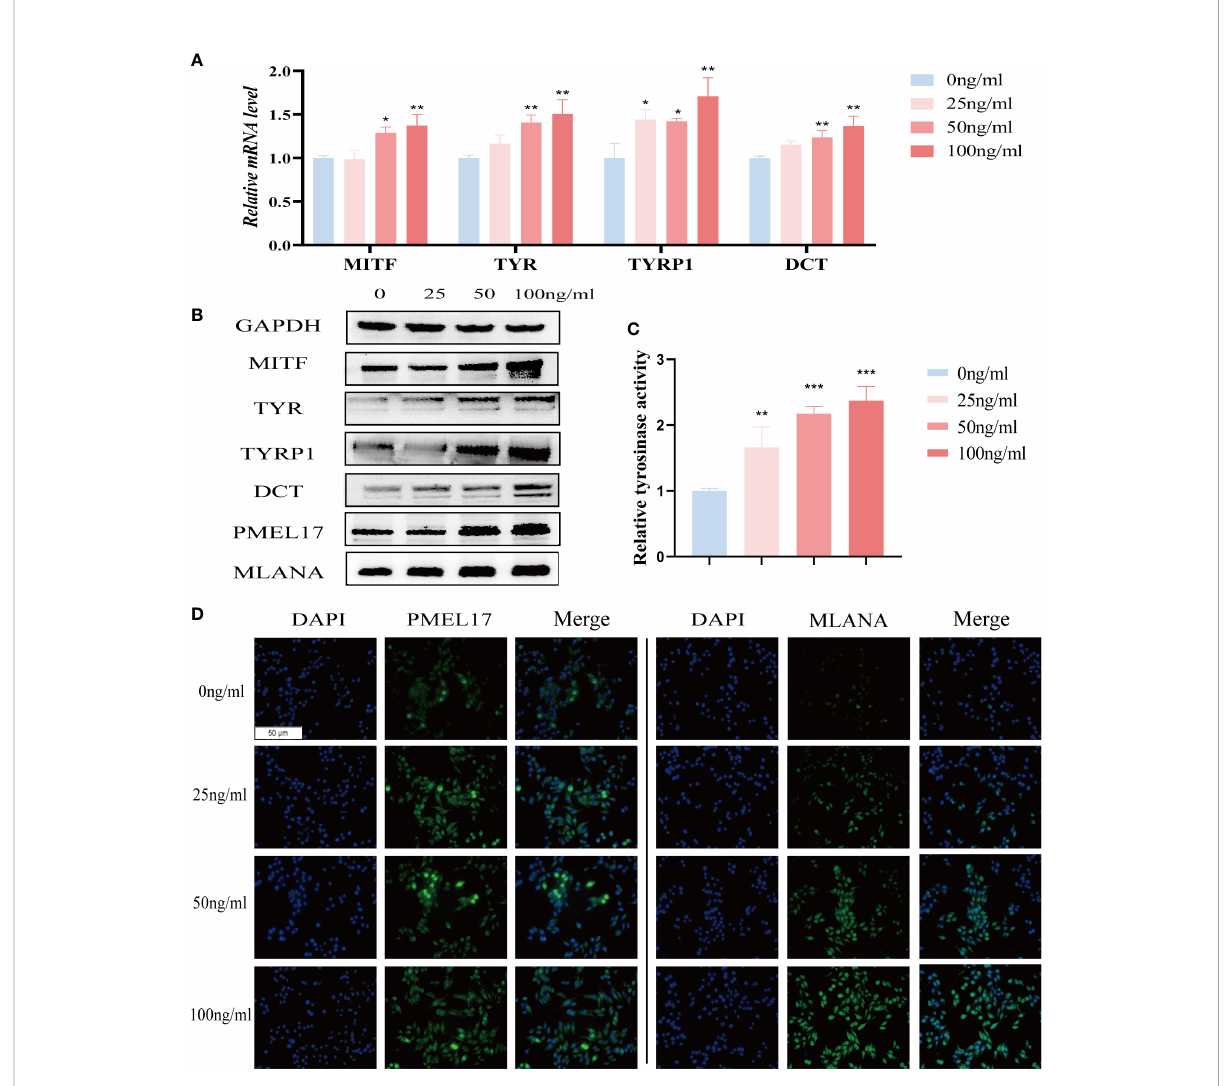
FIGURE 6 The role of IL-37 in melanogenesis. MNT1 cells were treated with different concentrations of IL-37. (A) qRT-PCR was used to examine the mRNA levels of melanogenesis-related genes. (B) The protein levels of MITF, TYR, TYRP1, DCT, PMEL17 and MLANA were analyzed by Western blotting. (C) Tyrosinase activity was measured by L-DOPA assay. (D) representative immuno fl uorescence images showing the distribution of melanosomes. (N = 3, ANOVA, error bar represents mean ± SEM, *P < 0.05, **P < 0.01, ***P <